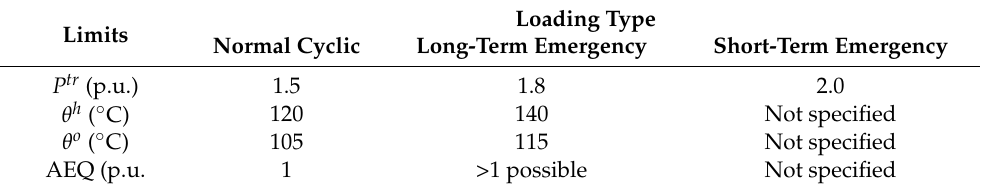
Table 1. Limits for distribution transformers applicable for different types of loadings